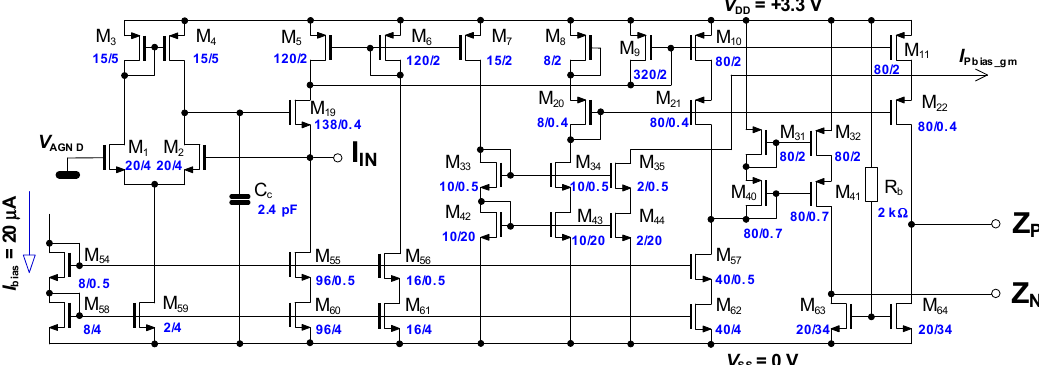
Figure 3. Slightly simplified schematic of the input and transimpedance stage.